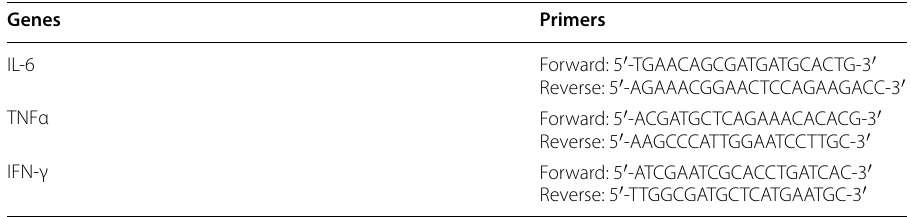
Table 1 Primers used for qPCR